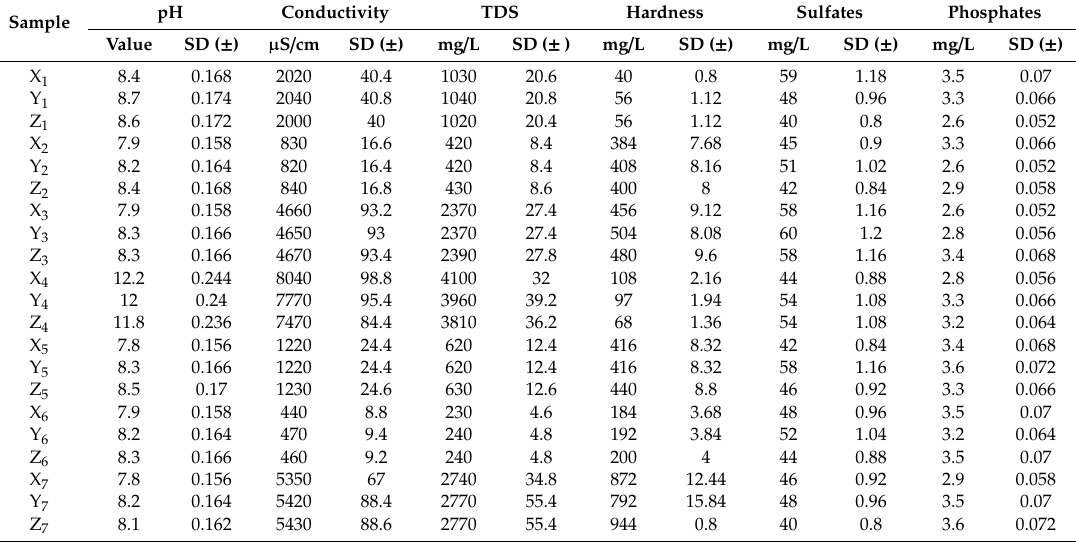
Table 3. Summary of quality parameters of samples with and without plasma treatment.